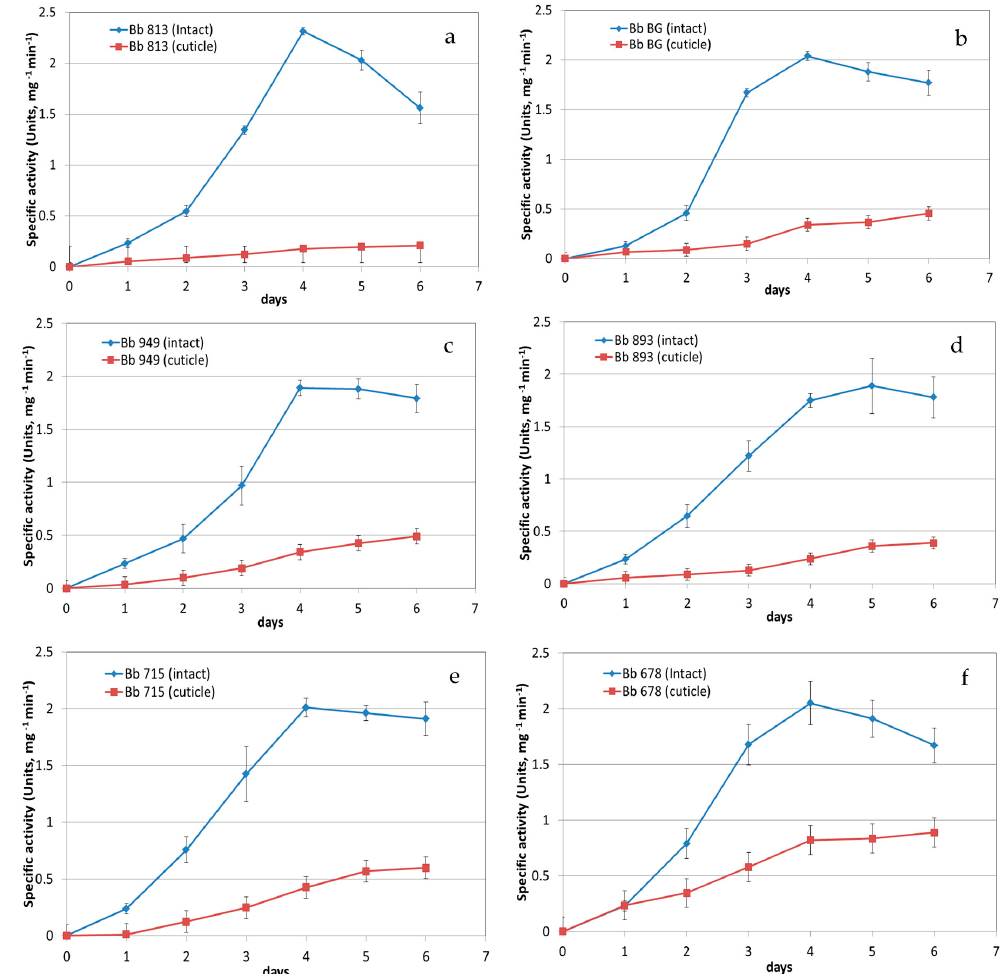
Figure 1. Exoenzymatic activity over time of six B. bassiana isolates assayed with Suc-Ala-Ala-Pro-Phe-pNA for detecting chymotrypsin-like activity in liquid shaking cultures using both the intact insect and the isolated cuticle diet medias indicated. Proteolytic curves were obtained for Bb813 ( a ), Bb BG ( b ), Bb 949 ( c ), Bb 893 ( d ), Bb 715 ( e ) and Bb 678 ( f ). Standard deviations has been